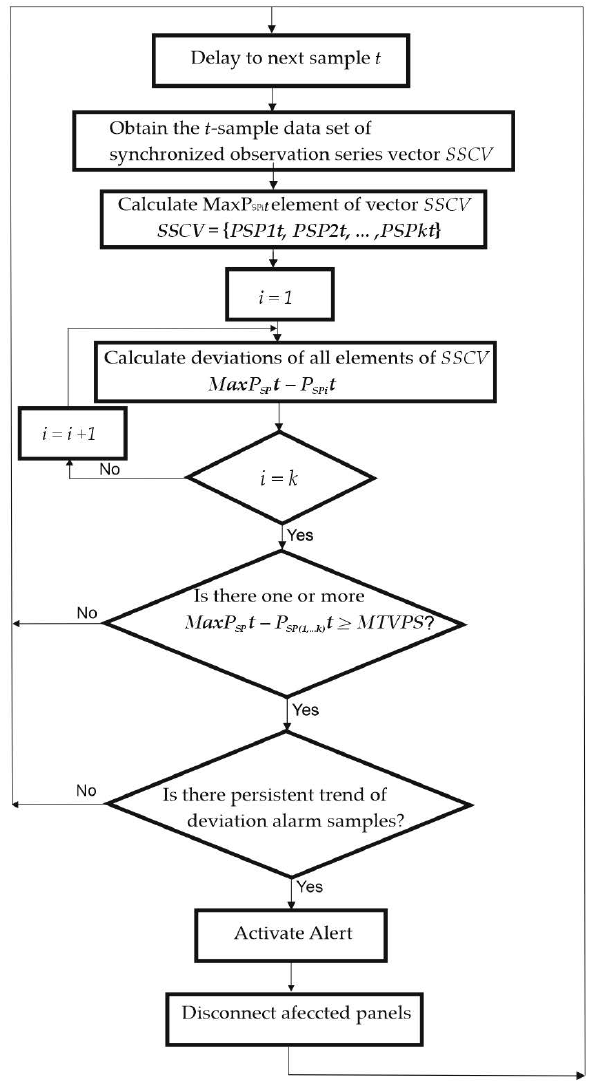
Figure 14. Online deviation trend comparative analysis algorithm flow